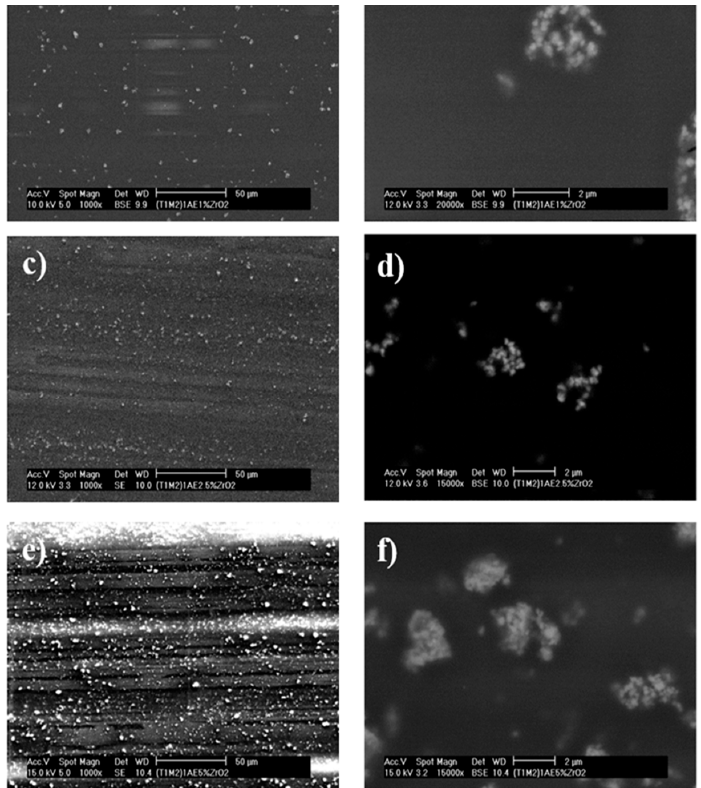
Figure 6. SEM topography images of coatings with ( a , b ) 1 wt.%, ( c , d ) 2.5 wt.%, and ( e , f ) 5 wt.% ZrO 2 at different magnifications.